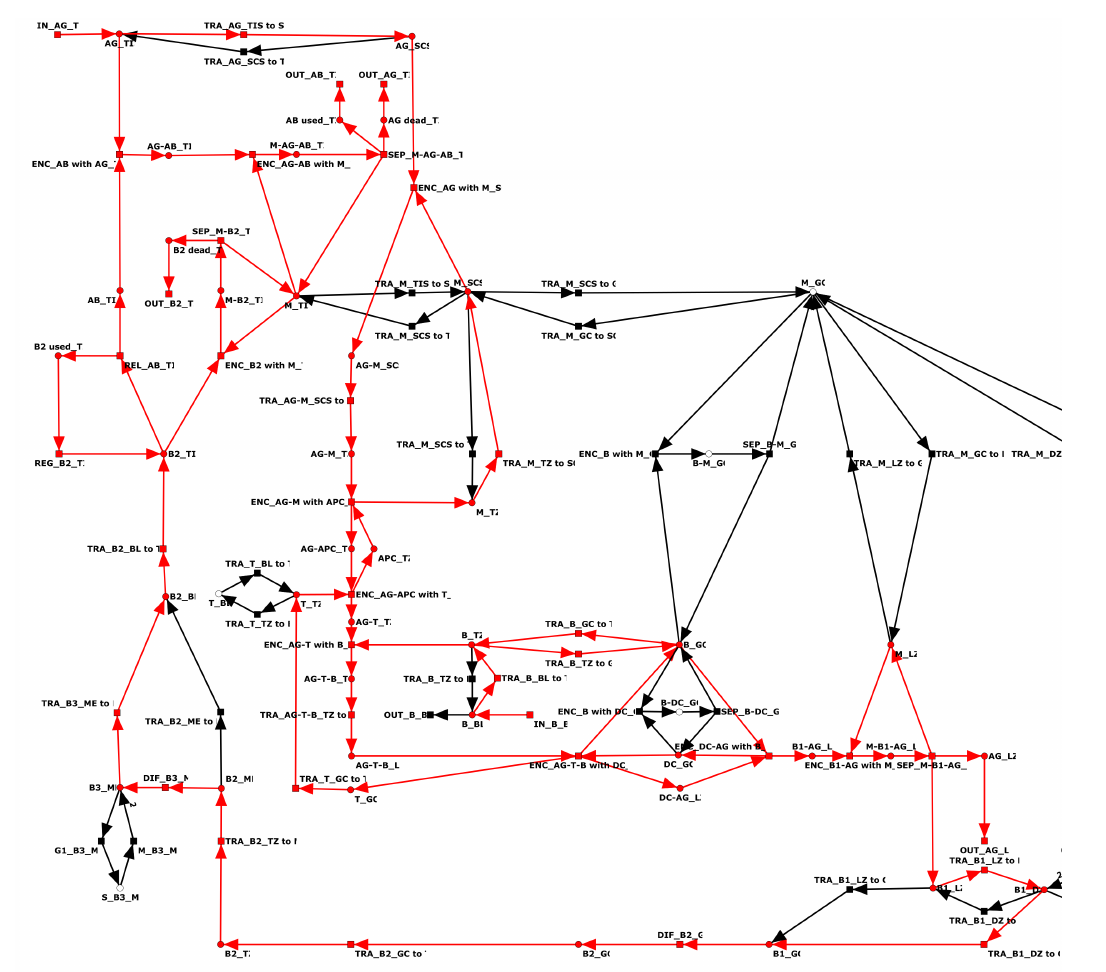
Figure 5. Manatee invariant MI-33: invasion of antigen leads to the activation of B cells, the production of antibodies, and the degradation of antigens. MI-33 is highlighted in red. Manatee invariant MI-33 characterizes a possible pathway of the immune response induced by the invasion of antigens and the activation of B cells. MI-33 combines transition invariants TI-6 and TI-8 (see Figure 3) as well